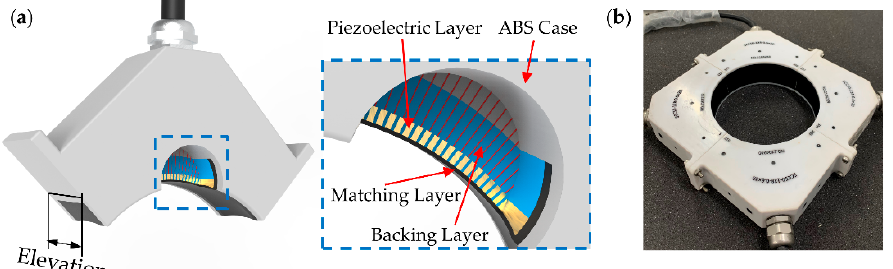
Figure 2. ( a ) The configuration of the transducer. The blue dotted box is a close-up of the transducer; ( b ) The photograph of the ring-array transducer. ( b ) The photograph of the ring-array